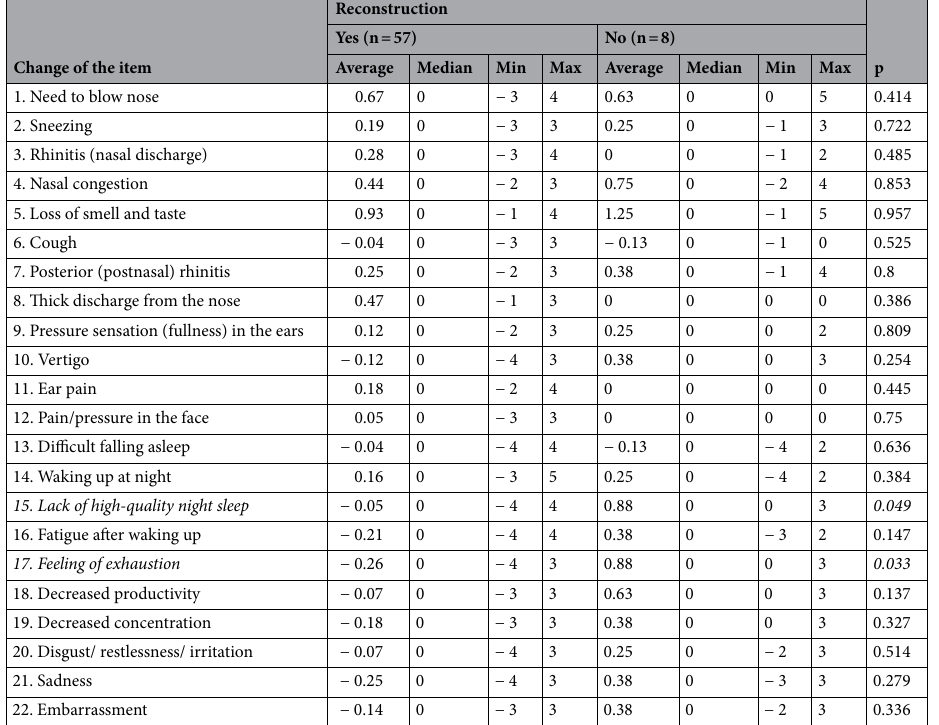
Table 5. Comparison of subgroups of patients with and without cranial base reconstruction. Calculated changes in the individual items are the differences of values (SNOT-22) measured before and after the treatment (positive changes denote an increase—deterioration of values; negative changes denote a decrease— improvement of values). Items with statistically significant change are marked in